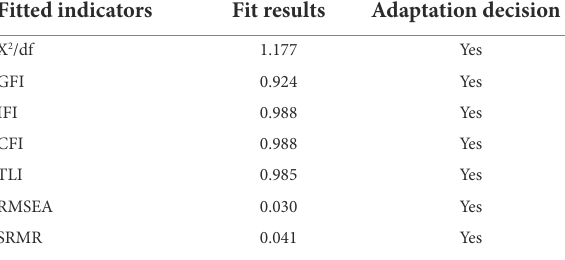
TABLE 8 Structural equation model fitness. Fitted